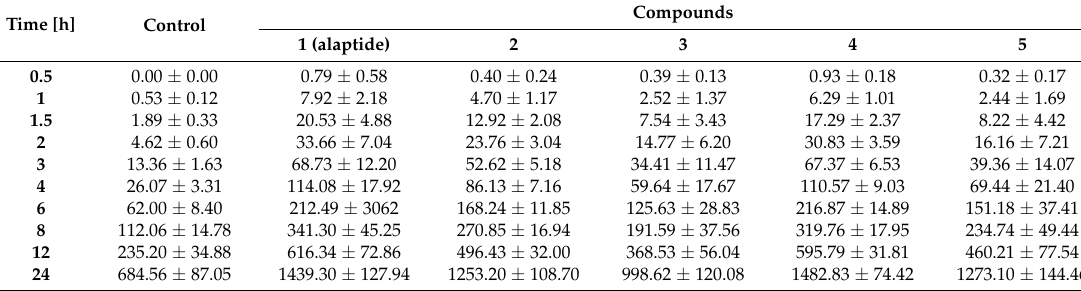
Table 2. Cumulative permeated amounts Q t of theophylline per unit area [ µ g/cm 2 ] from propylene glycol:water 1:1 without (control) and with CPEs 1–5 achieved in In vitro transdermal permeation experiments using Franz diffusion cell. Q t values are expressed as mean ± SD ( n = 5